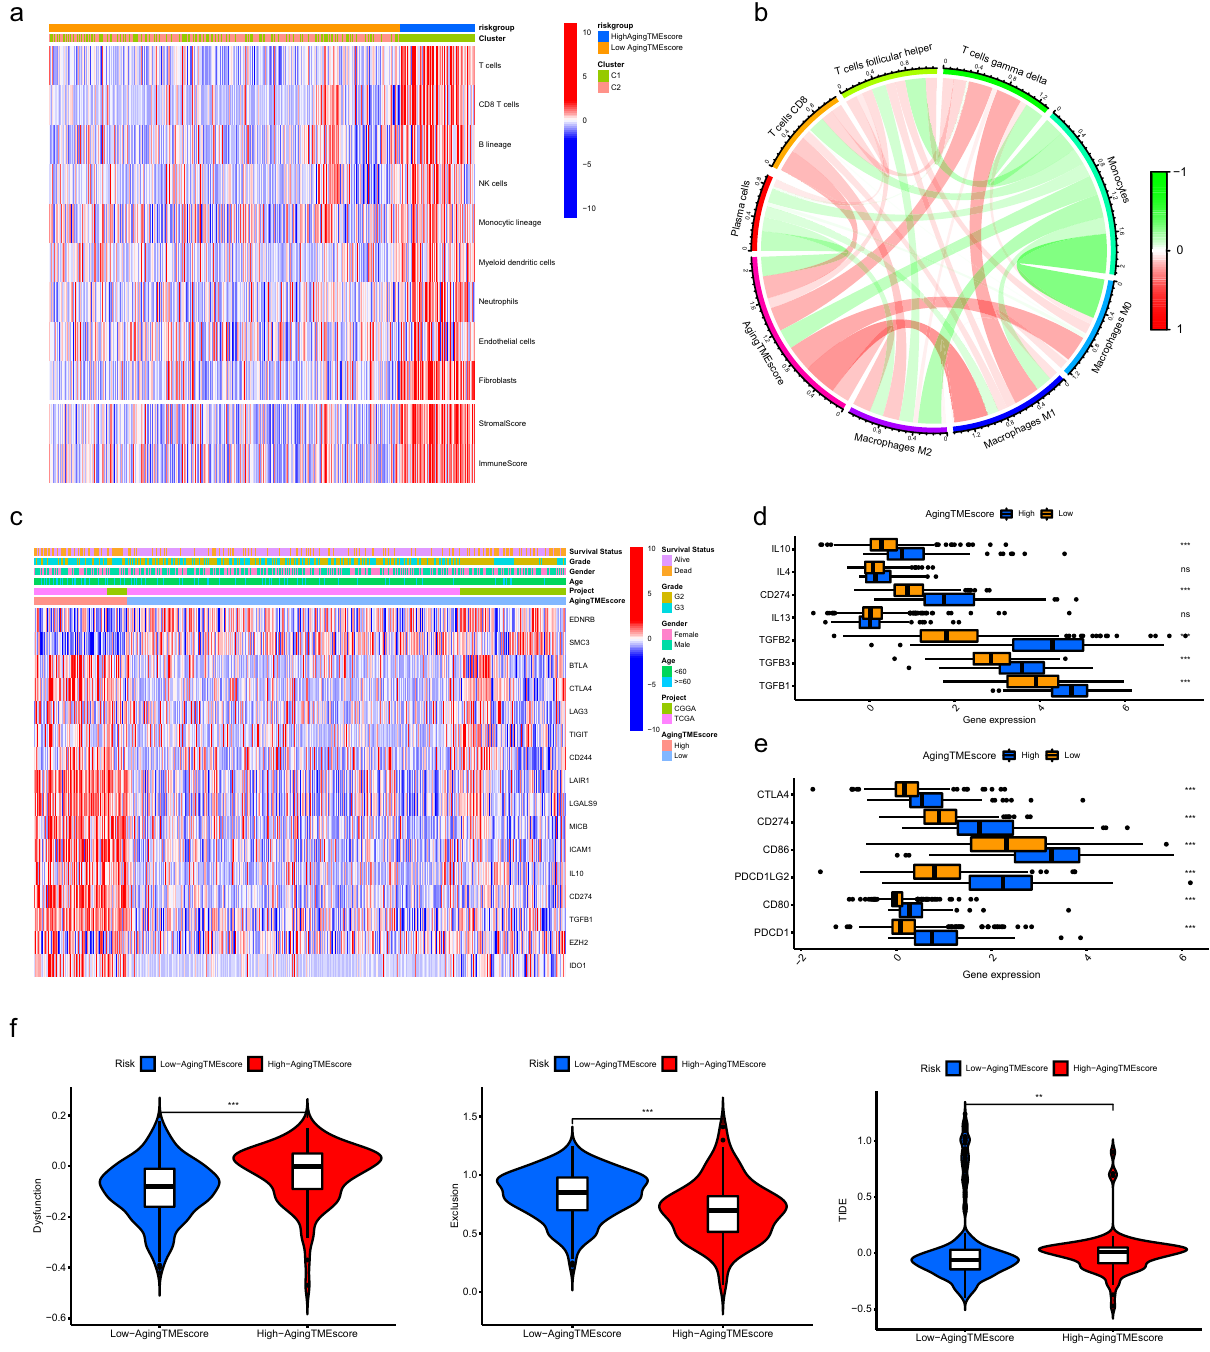
Figure 6. Immunosuppressive phenotype was identified in the TME of the high aging TME score group. ( a ) Results of the abundance of immune or stromal cells calculated by MCP counter algorithm and immune or stromal scores calculated by ESTIMATE algorithm. ( b ) The correlation between aging TME score and infiltrated immune cells evaluated by CIBERSORT algorithm. ( c ) The expression profiles of genes involved in the negative regulation of anti-tumor immune response between low and high aging TME score groups. ( d ) Differentially expression of the immune suppressive cytokines between the two groups. ( e ) Differentially expression of the common immune checkpoints between the two groups. ( f ) Comparisons of TIDE scores between the two groups. * means p < 0.05, ** means p < 0.01, and ***means p < 0.001. TME, tumor